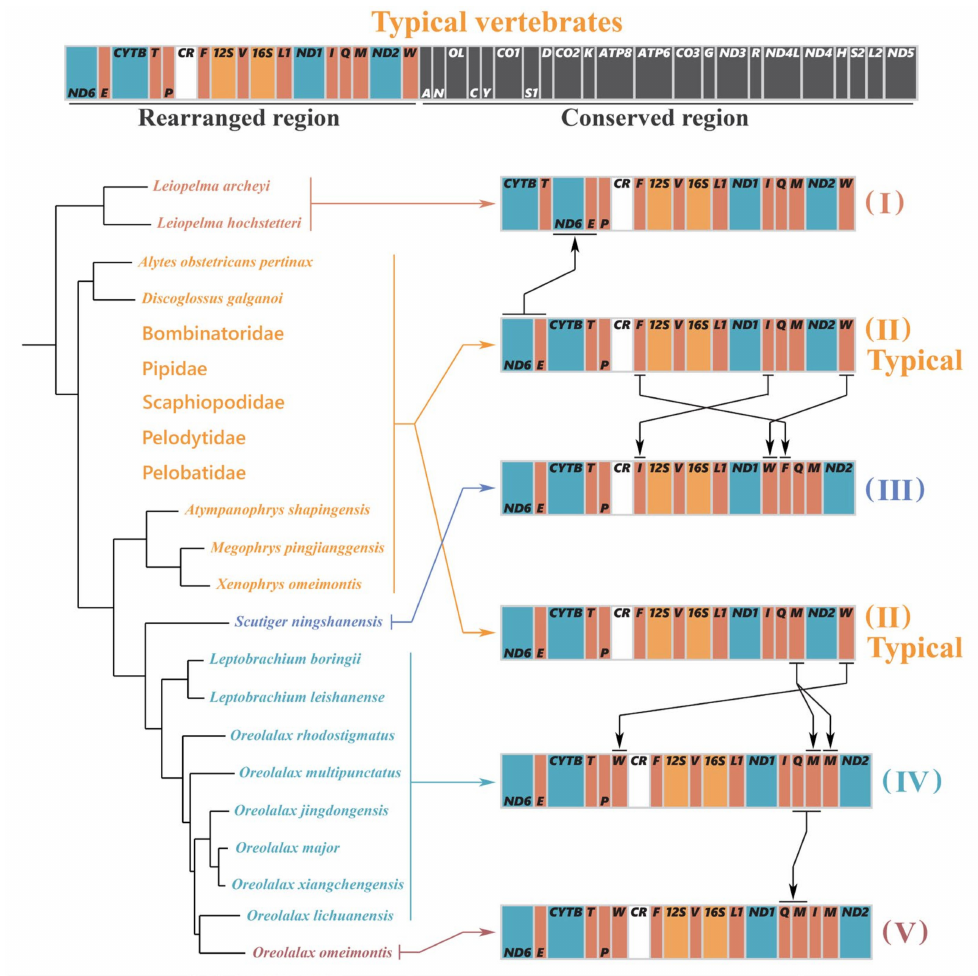
Figure 5. Diversity of gene rearrangements in Archaeobatrachia species. Lineages on which individual changes occurred were assigned using the parsimony criterion based on the phylogenetic framework (Figure 4). The mitogenomic features of each species on the tree are as follows: (I) translocation of nad6 and trnE ; (II) typical gene order; (III) translocation of trnI , trnW, and trnF ; (IV) duplication of trnM and translocation of trnW ; (V) translocation of trnQ and trnM